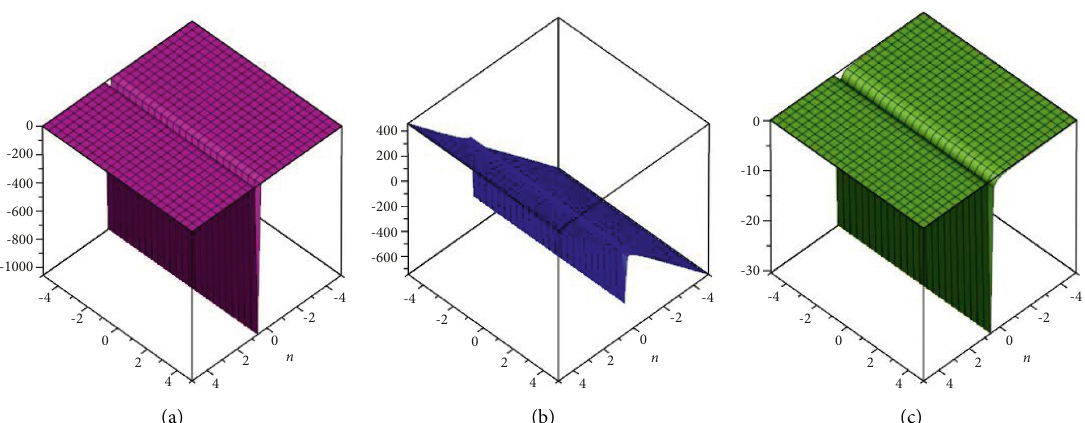
Figure 3: 3D plots for VAR ( Γ ) , IR 1 ( Γ ) , IR 2 ( Γ ) in Theorem 5.